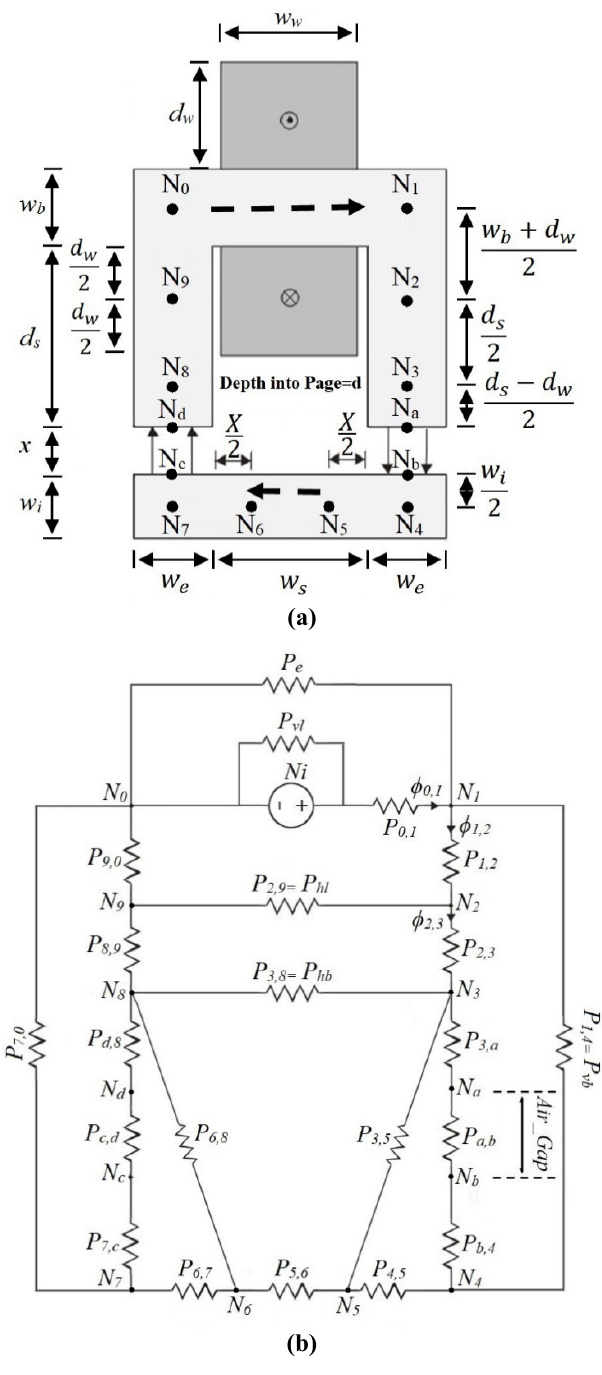
Figure 2: An electromagnet (a) Structure and Dimensions, (b) Proposed Magnetic Equivalent